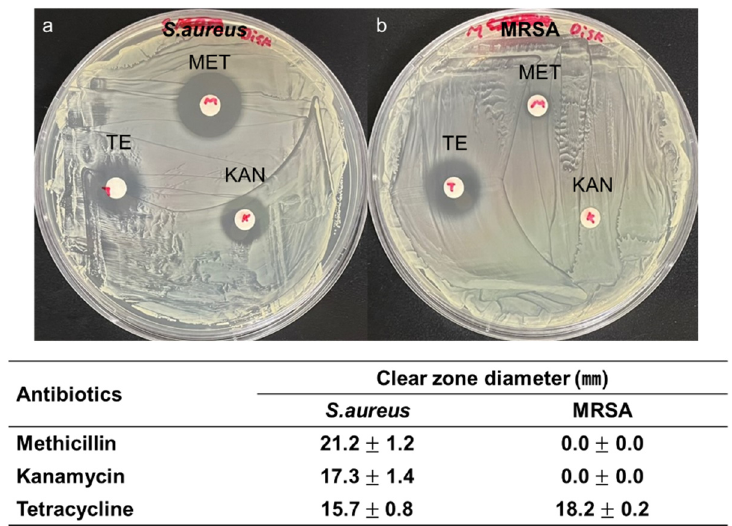
Figure 1. Components of Plasma Pipette ® and its schematic. ( a ) Each component of the pipette. ( b ) Block diagram of the internal structure of the pipette (blue line: gas supply path, black line: power line, red dot line: signal line, green dot line: feedback, and black dot–dash line: ground). ( c ) Pipette operation and plasma length.